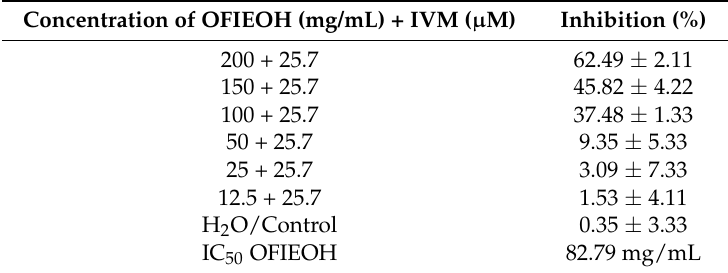
Table 5. Percentage ( ± standard deviation) of inhibition of migration of gastrointestinal nematodes using the larval migration test with the interaction of Opuntia ficus-indica essential oil (OFIEOH) and the concentration equivalent to IC 50 of